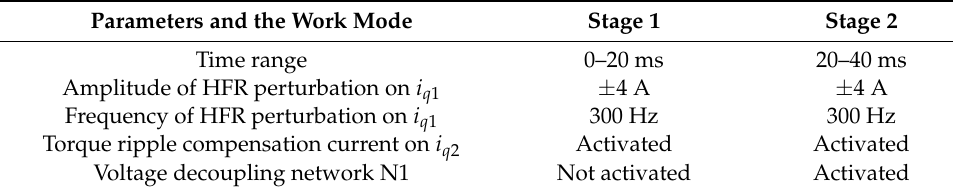
Table 4. Parameters and the work mode in two stages.